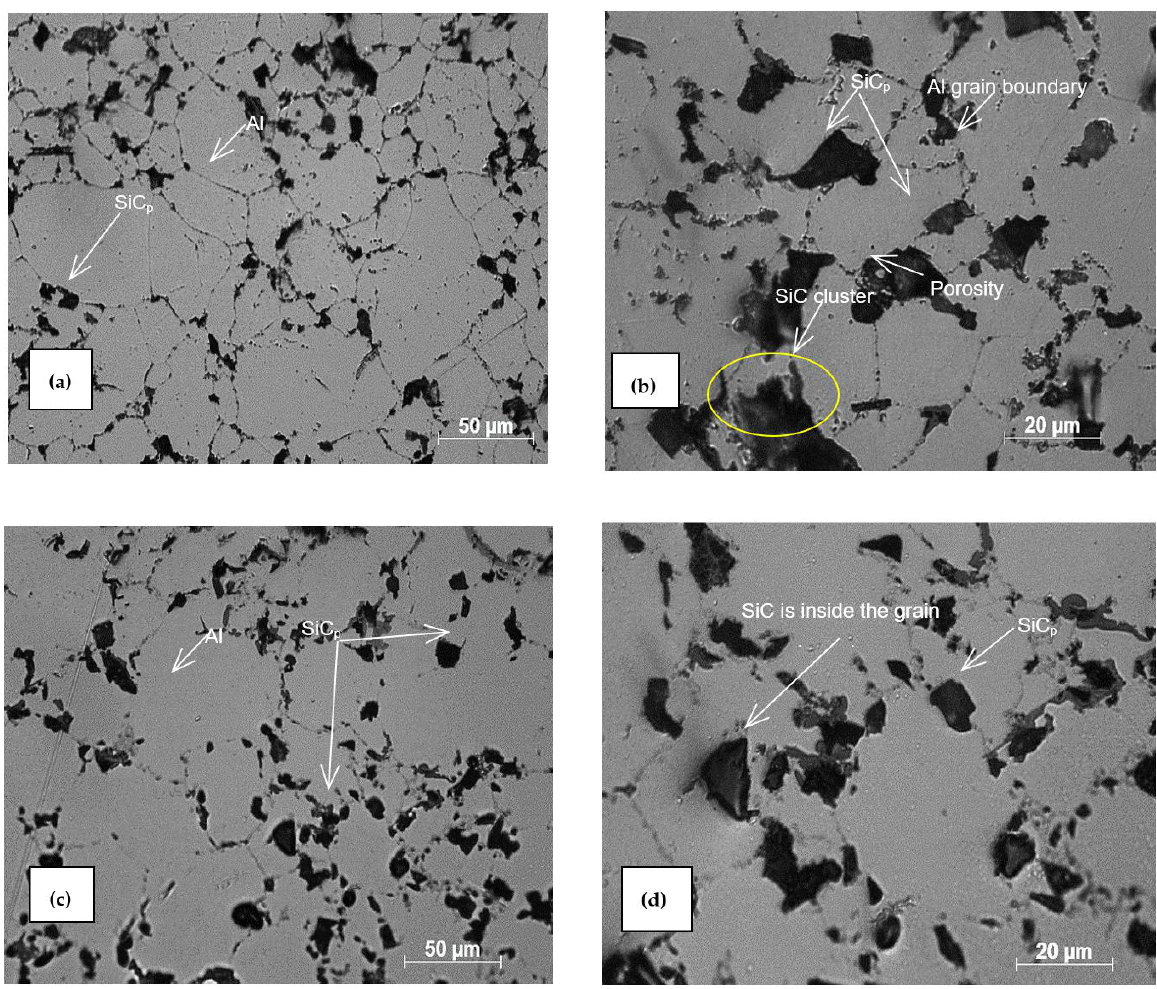
Figure 7. Micrographs of the Al/7 vol.% SiC p MMCs sintered at 700 ◦ C: ( a ) sintering time 30 min, 20 × magnification; ( b ) sintering time 30 min, 50 × magnification; ( c ) sintering time 90 min, 20 × magnification; ( d ) sintering time 90 min, 50 × magnification.